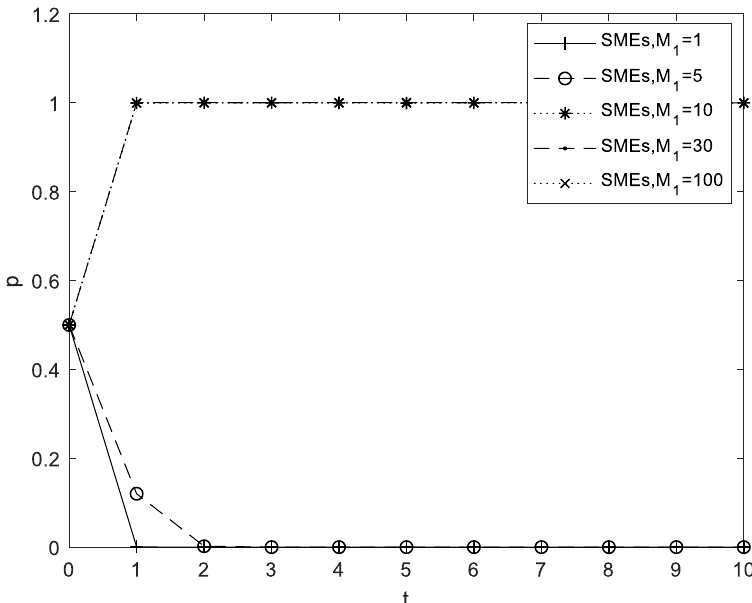
Figure 13. Effect of cash 𝑀 1 on the system evolution.